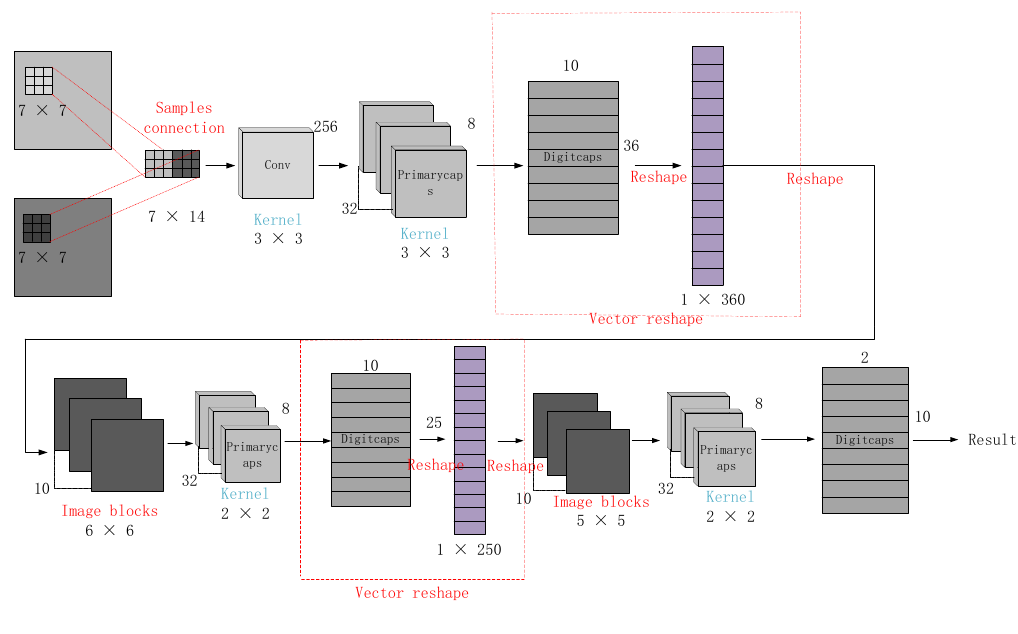
Figure 4. The flowchart of the capsule network deepened in a certain